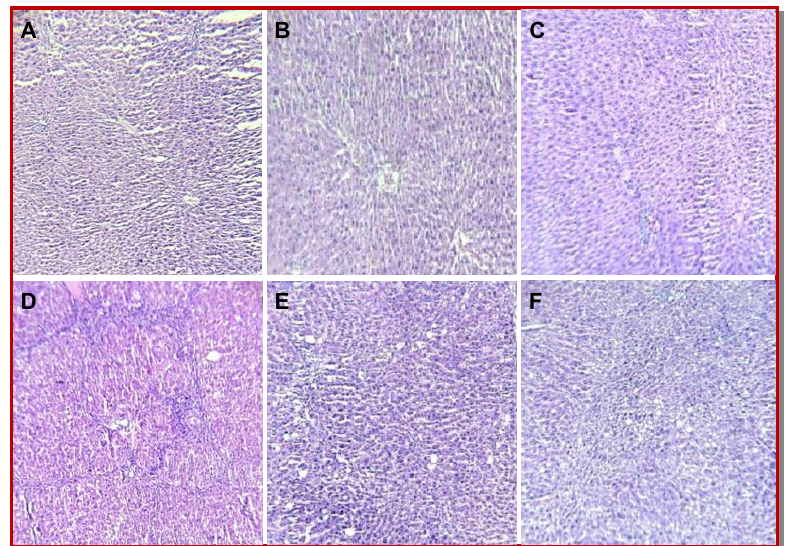
Figure 3: Microscopic evaluation of H & E stained liver tissue. Representative of n=5 from each group. A: Corn oil treatment, B: Corn oil + leaf extract (500 mg/kg), C: Corn oil + rhizome extract (500 mg/kg) D; CCL 4 treated, E: CCL 4 + leaf extract 500 mg/kg, F: Corn oil+ rhizome extract 500 mg/kg